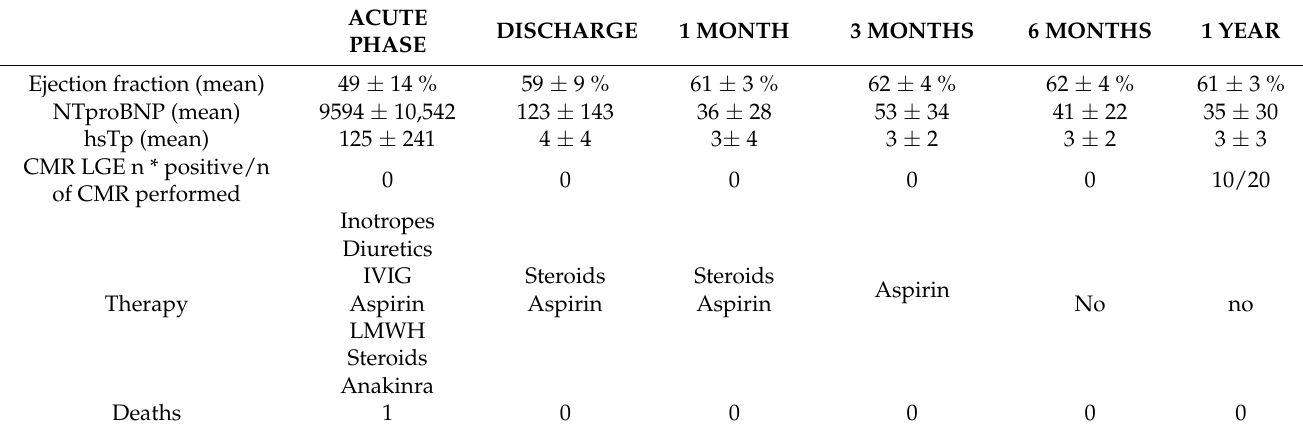
Table 3. Myocardial involvement, therapy and